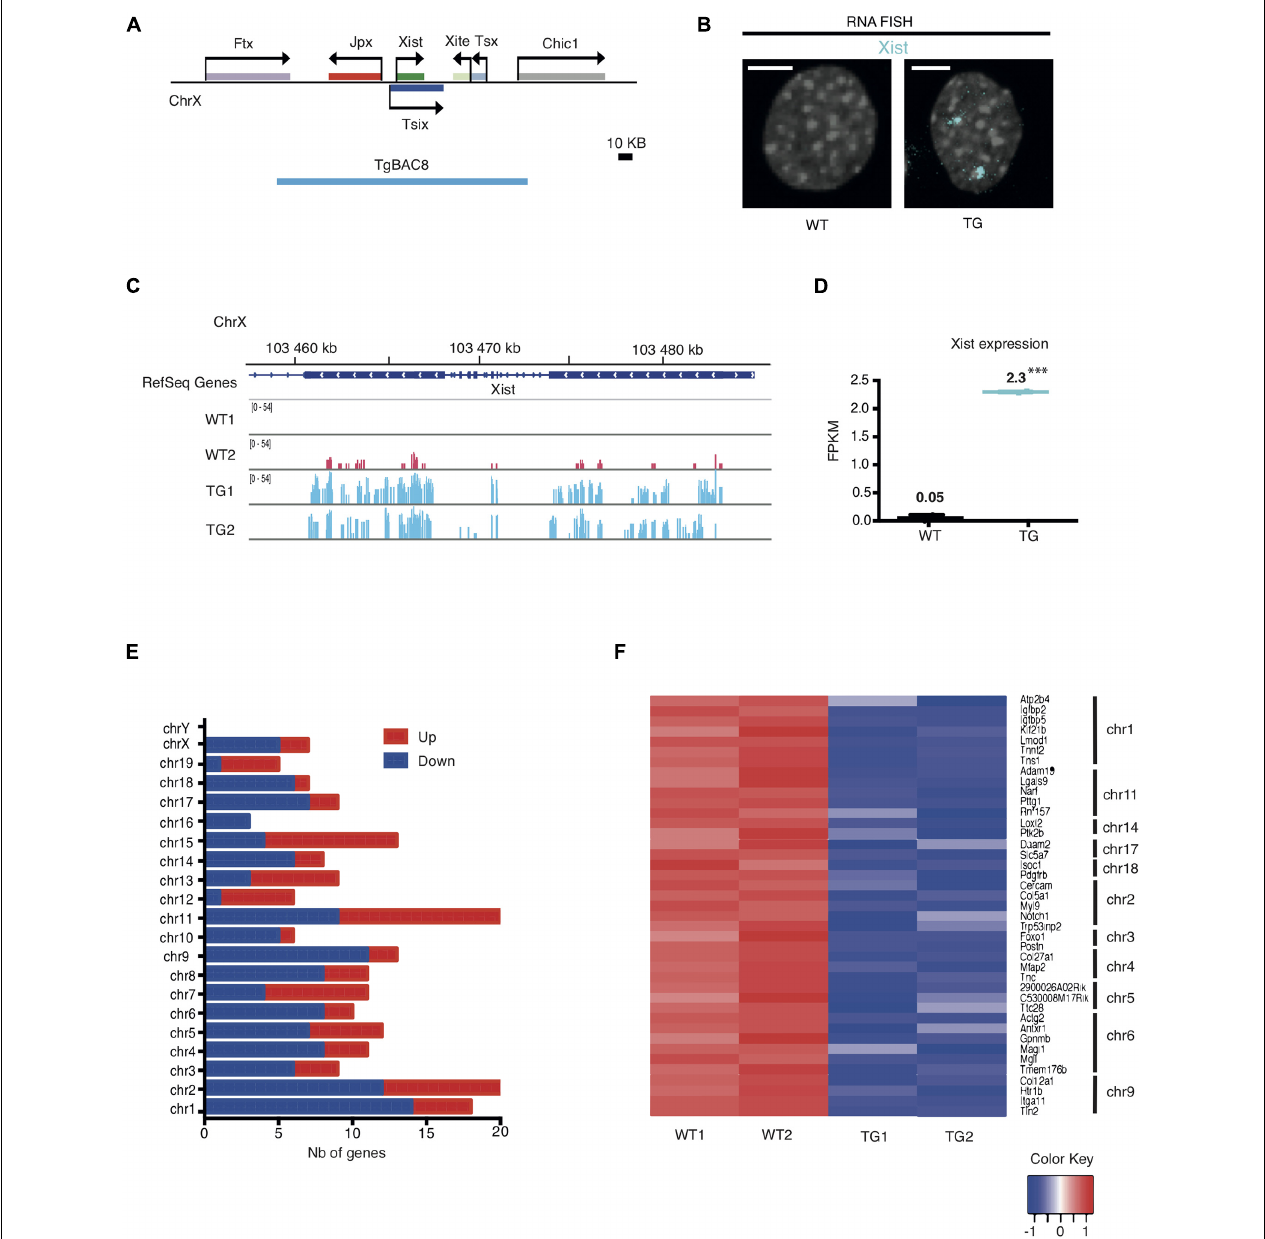
FIGURE 1 | Integration of the Xic sequence in an autosome leads to differential gene expression in mouse fibroblasts. (A) Map of the Xic locus and the coverage of the 200 kb TgBAC8 (blue line), which includes the non-coding genes: Xist , Jpx , Tsix, Xite , and Tsx . The transgene construct TgBAC8 was used in generating transgenic mice as described in Sun et al. (2015). (B) Xist RNA FISH in male Tail Tip Fibroblasts (TTFs) isolated from wildtype and transgenic mice. The fluorescent Cy5-labeled Xist probe (cyan) detected Xist RNA as two “clouds” in the TG cell; no Xist RNA present in the WT cell. WT and TG male cells are tetraploid due to SV40 large T-transformation. The scale bar is 5 µ m in length. (C) RNA-seq tracks showing Xist transcripts in WT and TG fibroblast samples in duplicate. (D) FPKM values for Xist transcripts in WT and TG fibroblast samples by RNA-seq. ∗∗∗ p < 0.001. (E) Histogram depicting the number (Nb) of down- and up-regulated genes categorized by chromosomes in TG cells by RNA-seq. (F) Heatmap of individual genes with RNA-seq transcripts in WT and TG cell samples in duplicate. Down-regulated genes in TG samples that are less than 5 Mb apart within the same chromosome are shown. The color key box represents the log2 of the FPKM